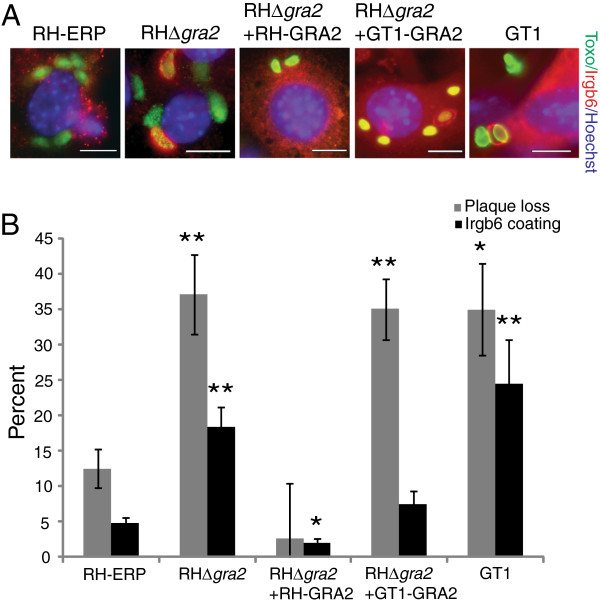
Differences in complementation of plaque loss and Irgb6 coating between RH-ERP and GT1 GRA2. (A) Mouse embryonic fibroblasts were stimulated with IFNγ for 24 hours, infected with RH-ERP, RHΔgra2, RHΔgra2+RH-ERP-GRA2, RHΔgra2+GT1-GRA2 and GT1 for 1 hour and stained for Irgb6 (red), Hoechst (blue) and SAG1 (RH-ERP, RHΔgra2 and GT1) or TdTomato (complemented strains) (green). Scale bars represent 10 μm. (B) Quantification of Irgb6 localization on the parasite containing vacuole and percentage plaque loss after 4–7 days on IFNγ stimulated MEFs compared to unstimulated MEFs. Mean + SEM, of at least 4 independent experiments, * p-value < 0.05 and ** p-value < 0.01, Student’s t-test compared to RH-ERP infected MEFs.